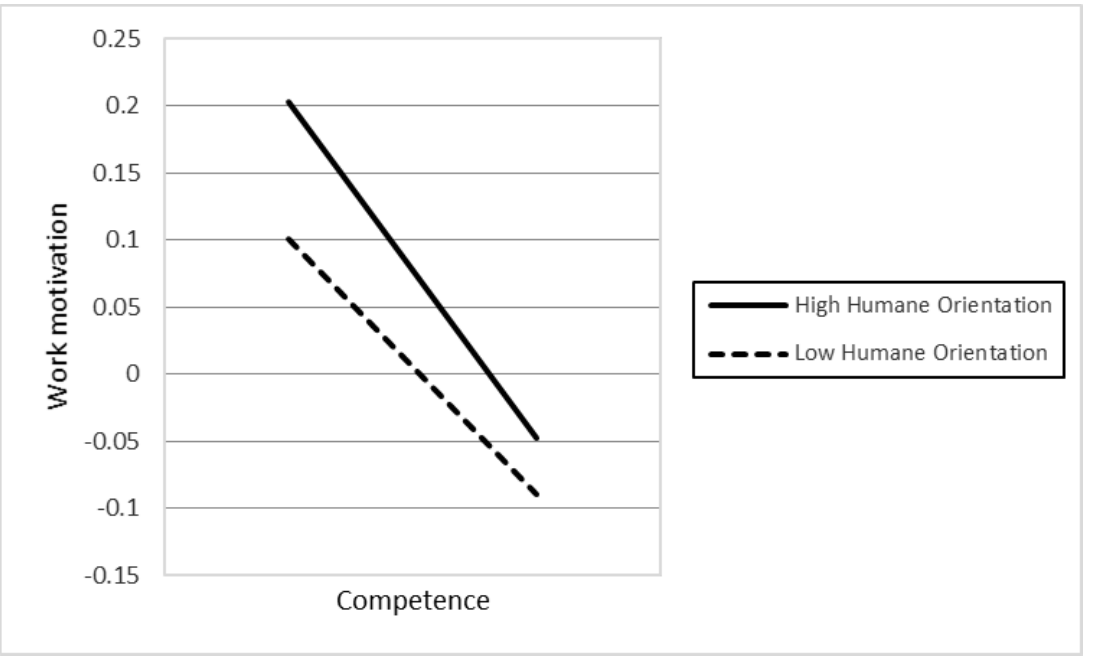
Figure 1. The association between competence and work motivation at different levels of humane orientation.